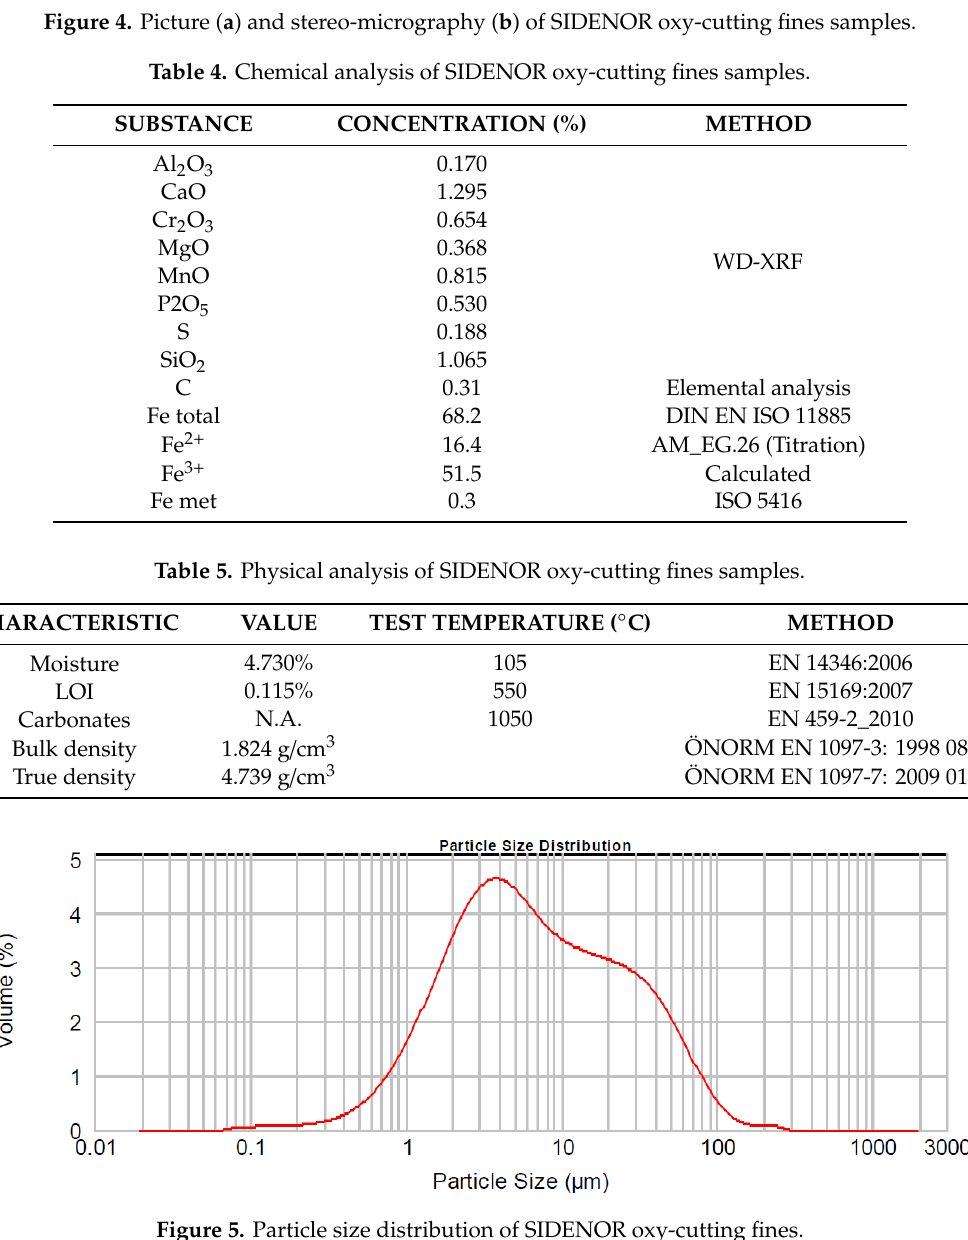
Figure 5. Particle size distribution of SIDENOR oxy-cutting fines.